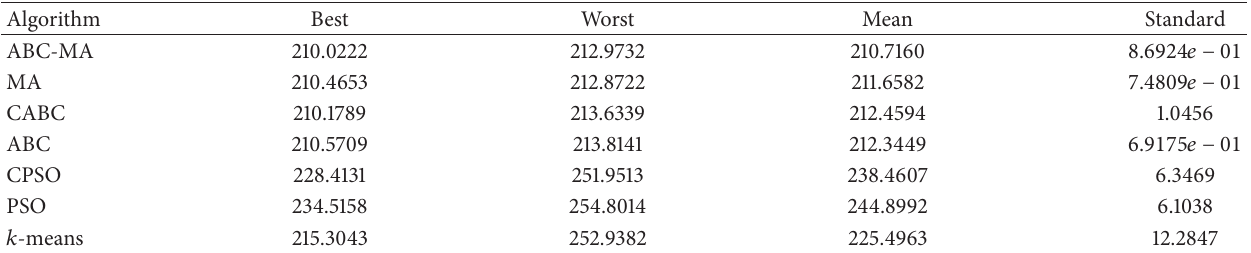
Table 7: Results obtained by the algorithms for 20 different runs on Ripley’s glass data.